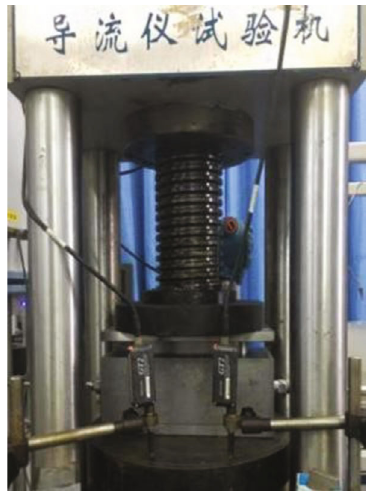
Figure 4: Test platform installation.